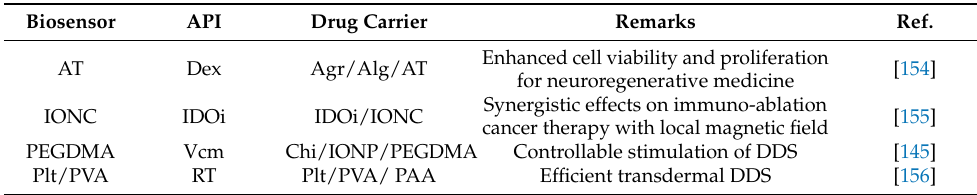
Table 9. Electrical triggers with biosensors of API in drug carriers and